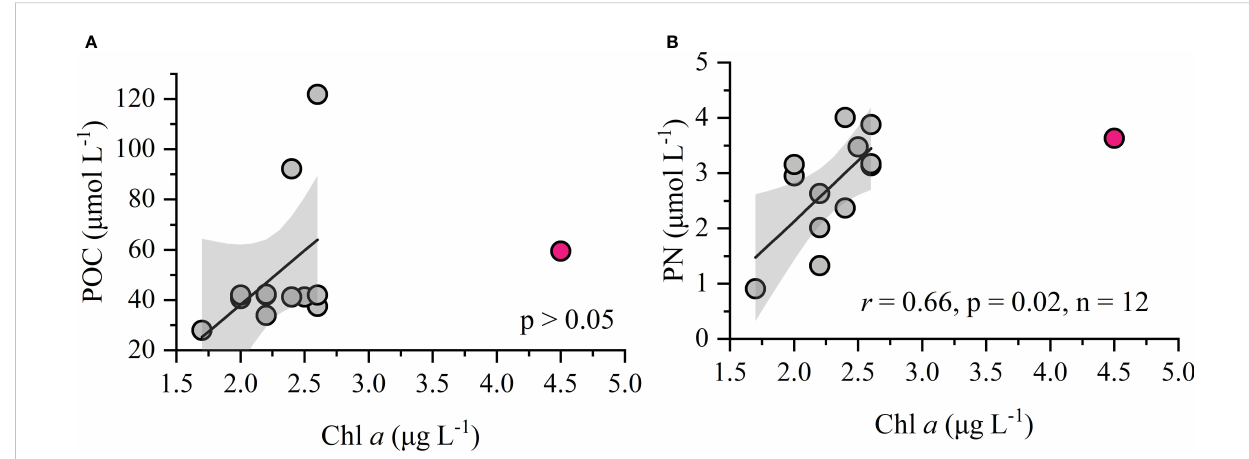
FIGURE 6 Relationships between POC, PN, and Chl a. (A) Relationship between POC and Chl a ; (B) Relationship between PN and Chl a . The red point is an abnormal value (outlier) that was excluded from linear fi tting. Gray shading represents the 95% con fi dence bands for the fi tted regression lines.